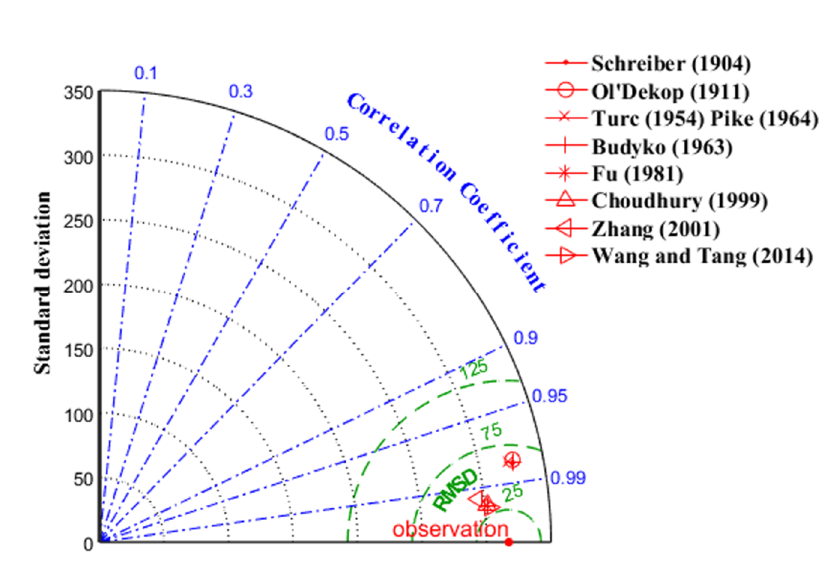
Figure 5. The Taylor diagram relates standard deviation, correlation, and root-mean-square deviation of simulation and observation.